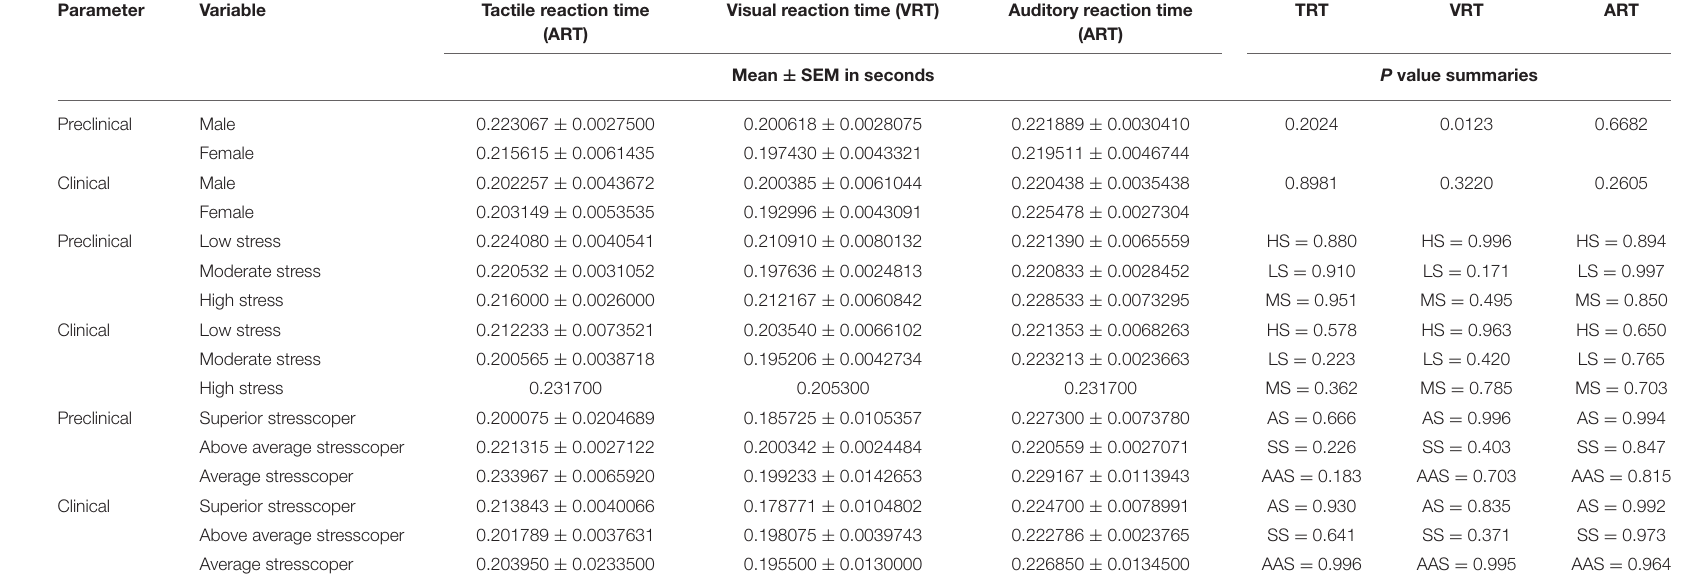
TABLE 4 | Reaction time among preclinical and clinical students in